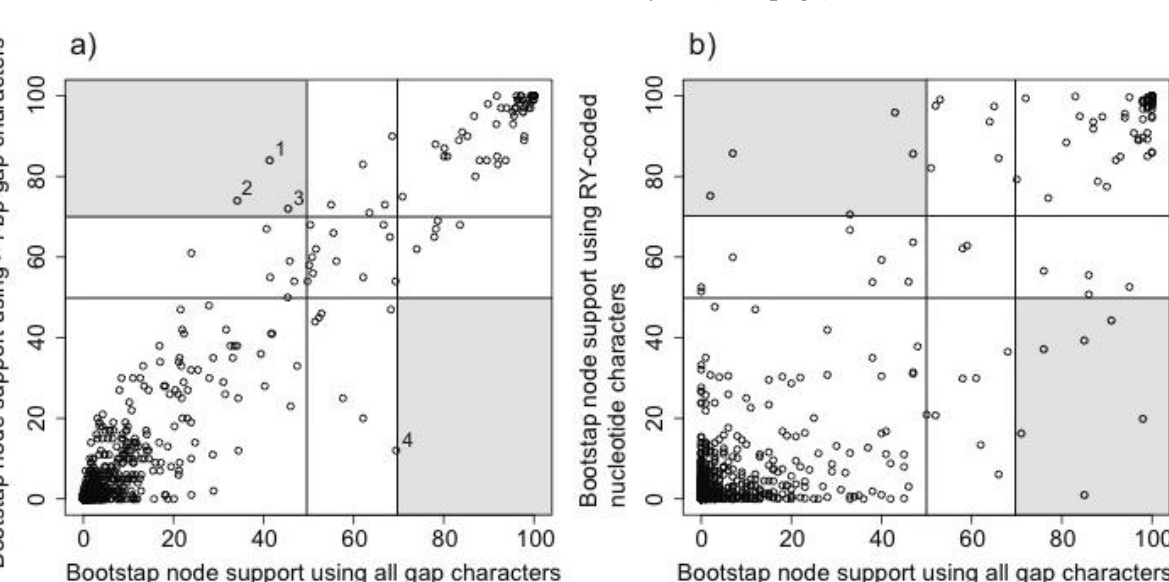
Figure 5. ( a ) Comparison of bootstrap support in trees based on all gap characters and gap characters >1-bp in length. Bipartitions th (cid:68)(cid:87)(cid:3)(cid:68)(cid:83)(cid:83)(cid:72)(cid:68)(cid:85)(cid:72)(cid:71)(cid:3)(cid:90)(cid:72)(cid:79)(cid:79)(cid:3)(cid:86)(cid:88)(cid:83)(cid:83)(cid:82)(cid:85)(cid:87)(cid:72)(cid:71)(cid:3)(cid:11)(cid:149)(cid:26)(cid:19)(cid:8)(cid:3)(cid:69)(cid:82)(cid:82)(cid:87)(cid:86)(cid:87)(cid:85)(cid:68)(cid:83)(cid:12)(cid:3)(cid:69)(cid:92)(cid:3)(cid:82)(cid:81)(cid:72)(cid:3) analysis and poorly supported (<50% bootstrap) in the other are shaded. Numbers correspond to the following bipartitions: 1. Ardea - Cochlearius-Eudocimus ; 2. Alisterus - Psittacula